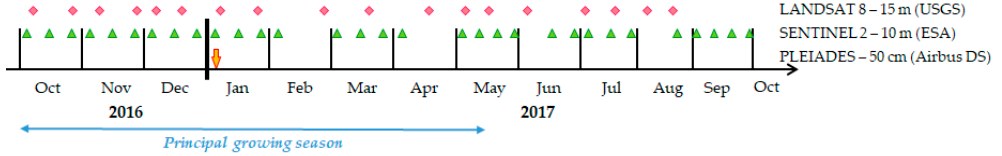
Figure 2. Chronogram of satellite acquisitions over the study period. The main growing season is highlighted in light blue color. USGS, United States Geological Survey; ESA, European Spatial Agency; Airbus DS, Defence and Space.